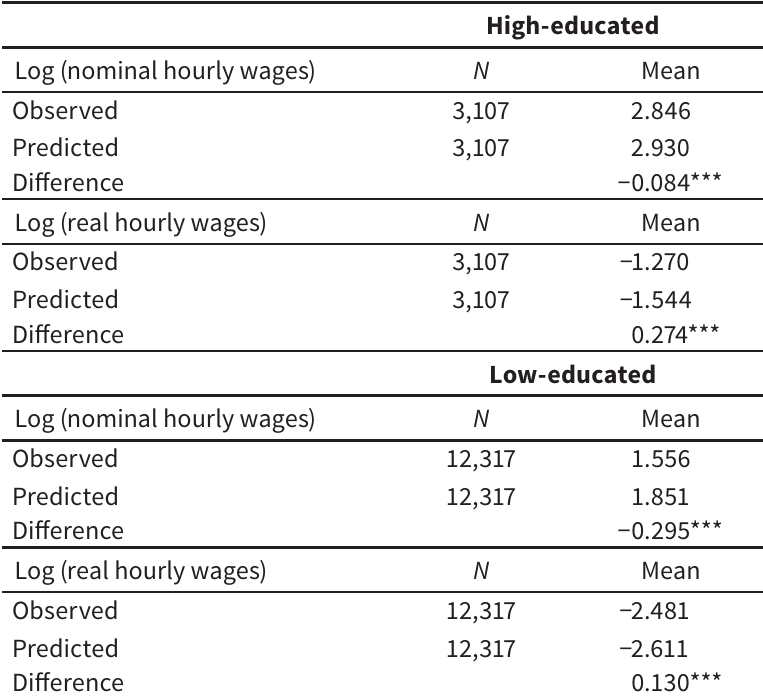
Differences in actual and predicted wages for metropolitan out-migrants, by education level